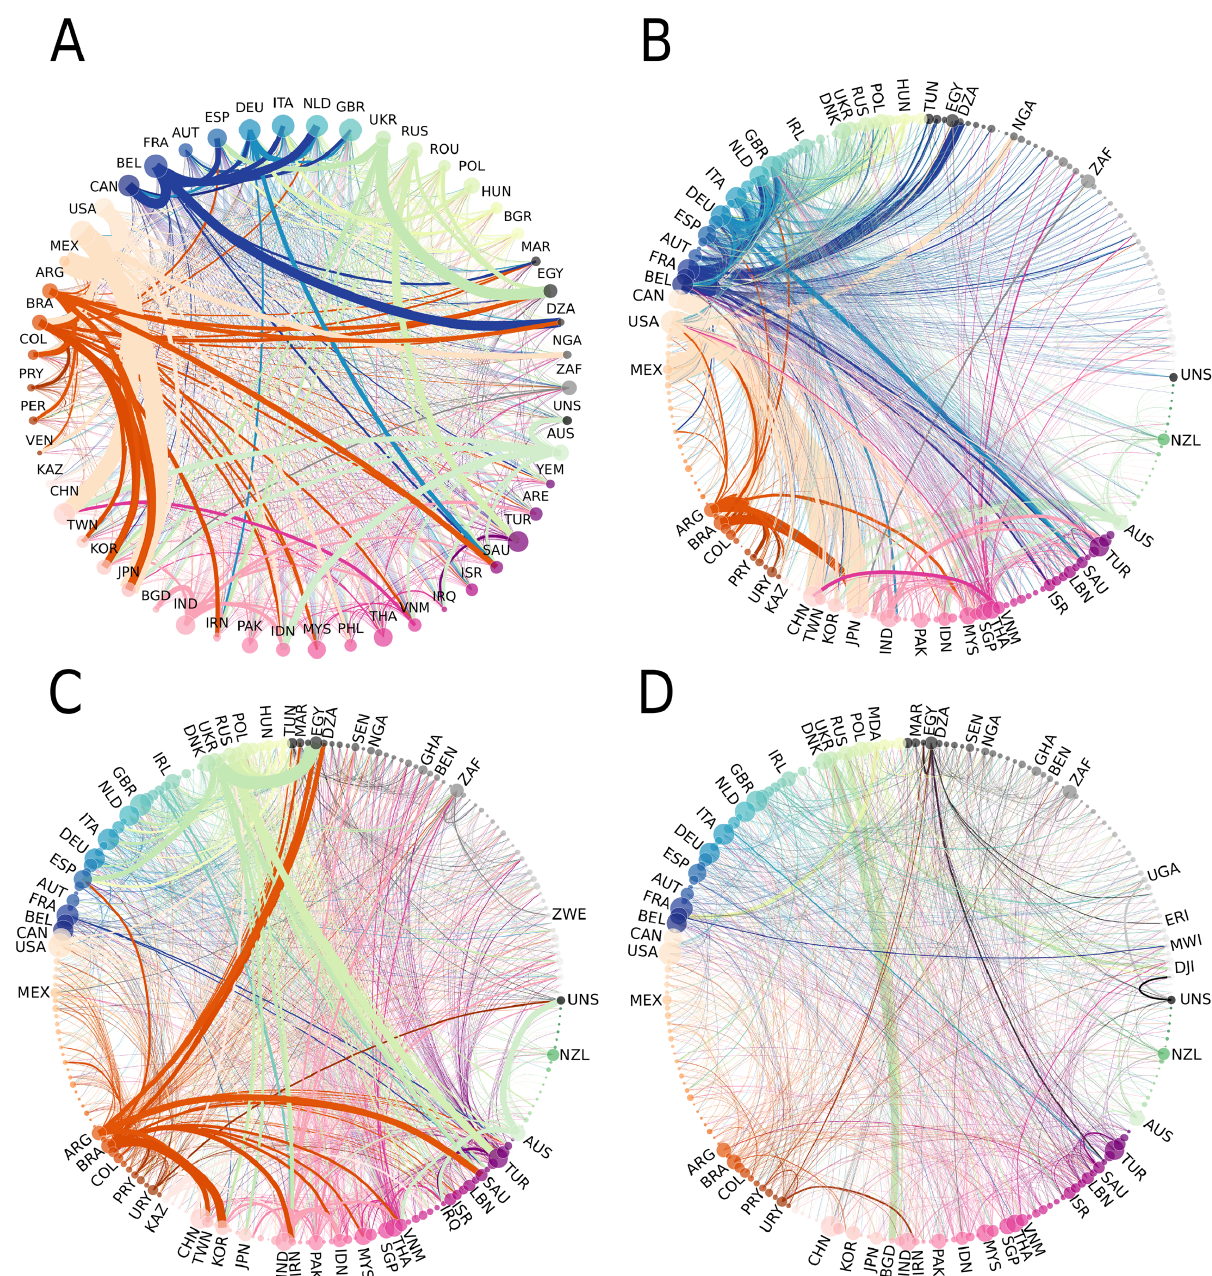
Fig 4. The total world cereals trade network and its decomposition in the three subnetworks in 2013. The countries are ranked by continent and the size of nodes is weighted by the total number of trades k tot . The color code indicates the continent group: grey, Africa, green Oceania, blue to yellow Europe, orange to red America, pink Asia. The edges are weighted by the traded mass and the colour corresponds to the country of destination. A. World cereal network . The graph is limited to the 50 most important countries and their trades. The total network counts 210 nodes and 8700 links. The total traded mass is 405.7 million tons. The degree distribution is of type exponential. B. Backbone subnetwork . This network counts 202 nodes and 2135 links. The traded mass is 276 million tons, which represents 68% of the world trade in 2013. The degree distribution follows a power law indicating that the network is scale-free. C. Intermediate subnetwork . This network counts 208 nodes and 4685 links. The traded mass is 121 million tons, which represents 29% of total trade in 2013. The degree distribution is of type exponential. D. Transient subnetwork . This network counts 207 nodes and 1880 links. The traded mass is 8 million tons, which represents about 2% of total trade in 2013. The degree distribution is of type exponential.